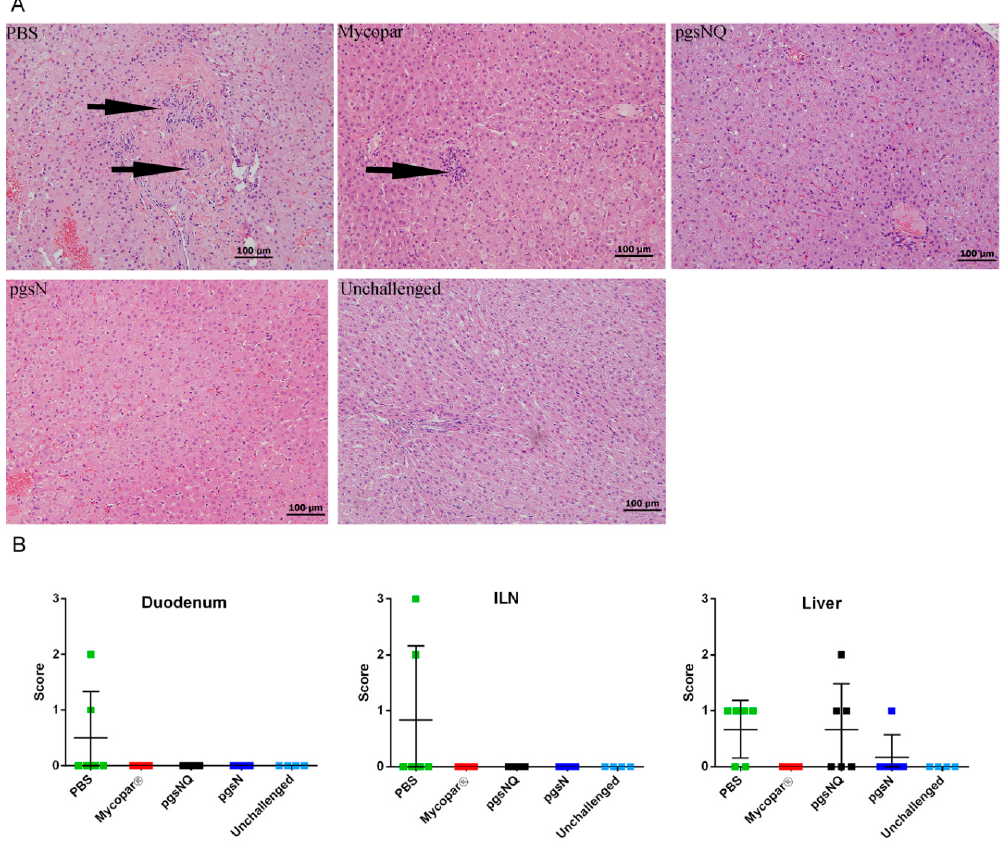
Figure 2. Histopathology of tissues from vaccinated calves following challenge with M. paratuberculosis JTC 1285. ( A ) Liver sections stained with hematoxylin and eosin collected from calves vaccinated with phosphate-buffered saline (PBS), Mycopar, pgsNQ, pgsN and unchallenged at 12 MPC. Arrows indicate granuloma infiltrates. ( B ) Granulomatous inflammation scores in duodenum, ileal lymph node (ILN) and liver at 12 MPC. Data are expressed as mean values with error bars representing the standard deviation. Individual calves are indicated by solid box. Table 1. M. paratuberculosis challenge strain fecal shedding.